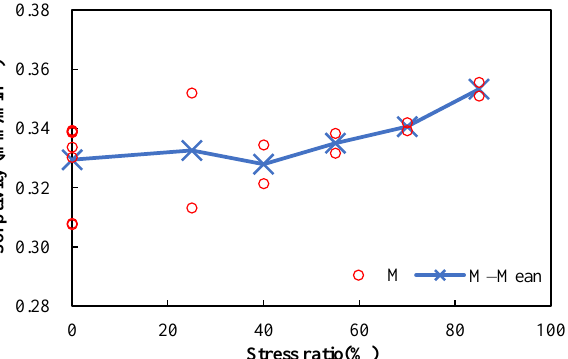
Figure 9. Sorptivities of damaged mortar specimens (w/c = 0.5) after different compressive stress levels.